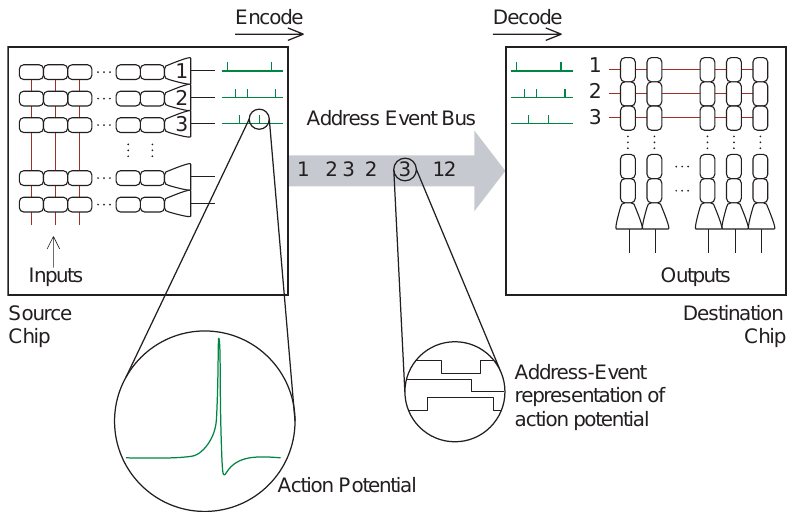
Figure 10 . Schematic diagram of an AER chip to chip communication example. As soon as a sending node on the source chip generates an event, its address is written on the Address-Event Bus. The des- tination chip decodes the address-events as they arrive and routes them to the corresponding receiving